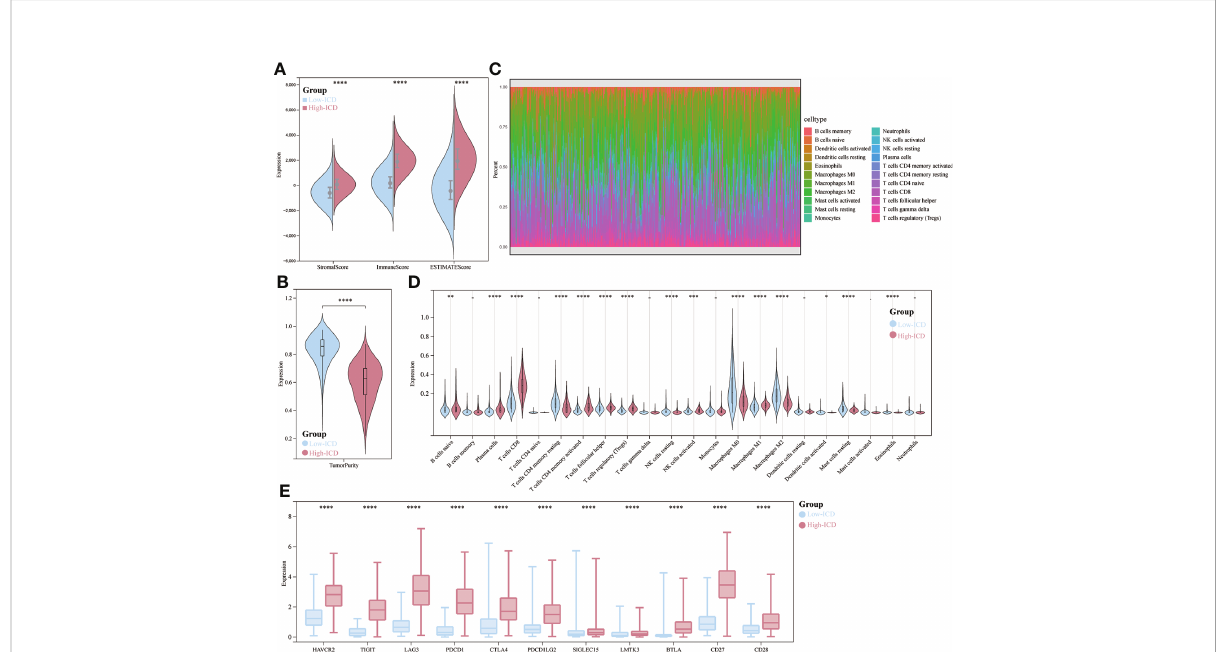
FIGURE 5 Immune landscape of ICD-high and ICD-low subtypes. (A, B) Fractional violin plots showing median and interquartile estimates of each immune score and tumor purity score; (C) relative proportions of immune in fi ltration in ICD-high and ICD-low subtypes; (D) Violin plots showing immune cells that differ signi fi cantly between subtypes; (E) box plots indicating differential expression of multiple immune checkpoints. *p < 0.05, **p < 0.01, ***p < 0.001, & ****p <